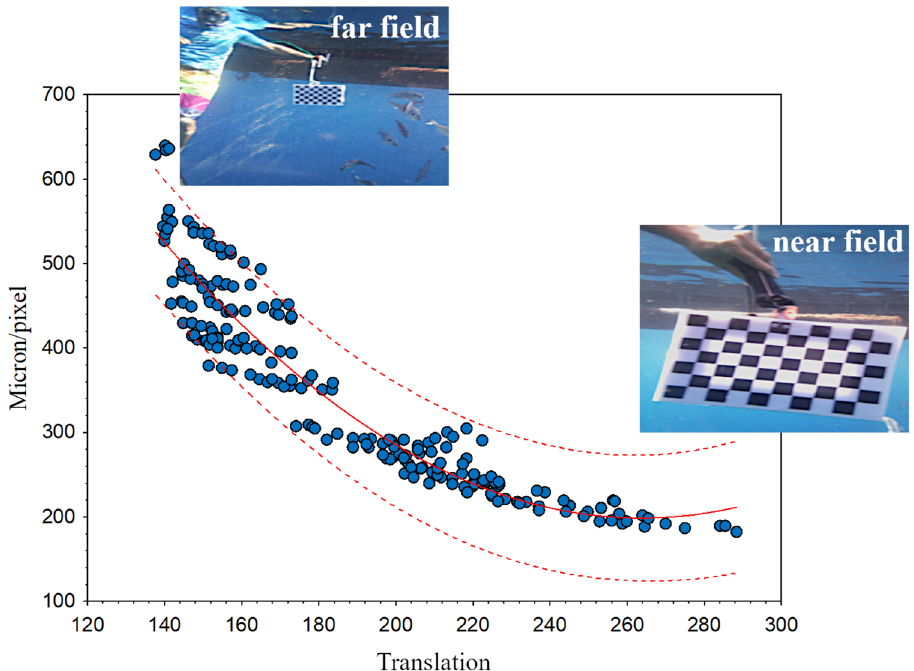
Figure 1. Scatterplot of the mean translation of the landmarks (n = 208) and their corresponding micron/pixel ratio (cubic polynomial fitting ± 0.95 confidence